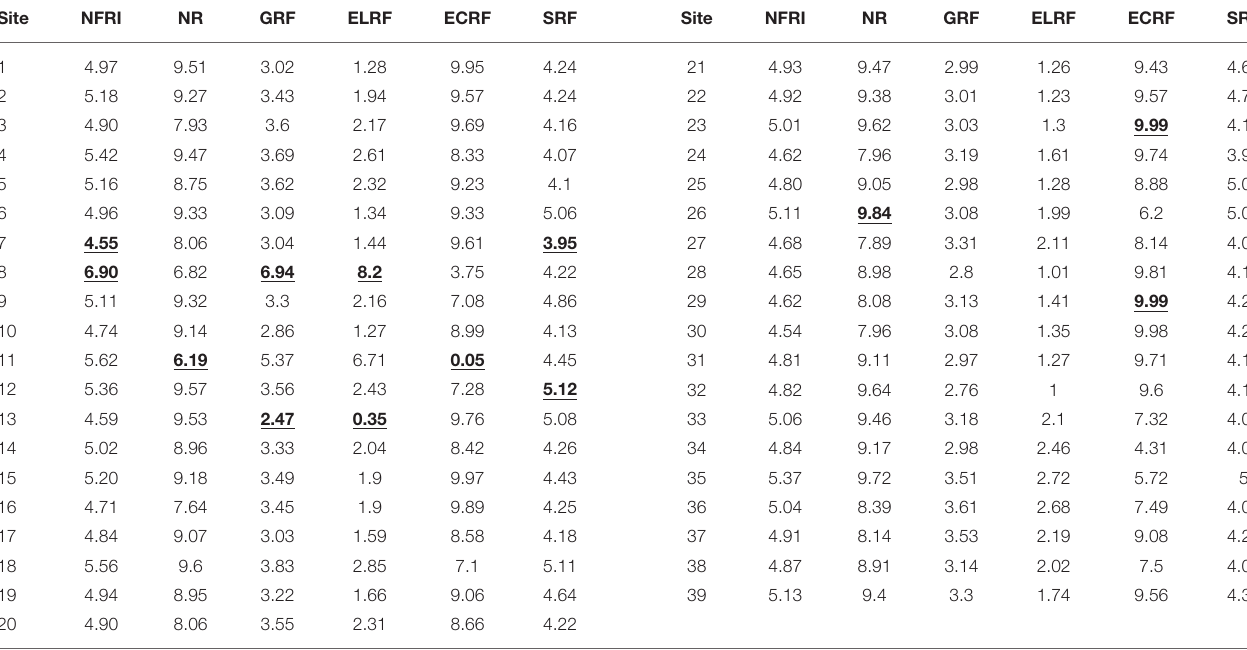
TABLE 2 | Values obtained for the 39 study sites for the different elements of the multicriteria analysis. Site